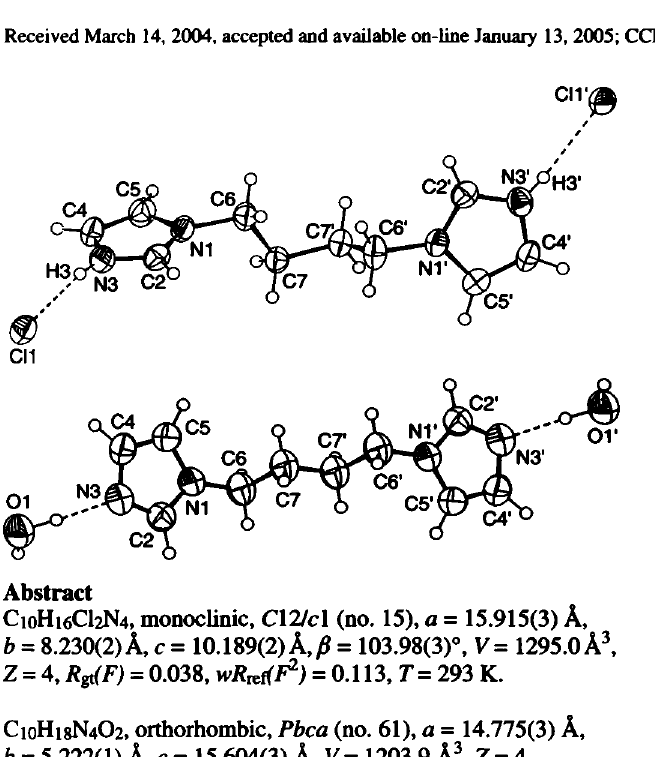
Table 1. Data collection and handling.